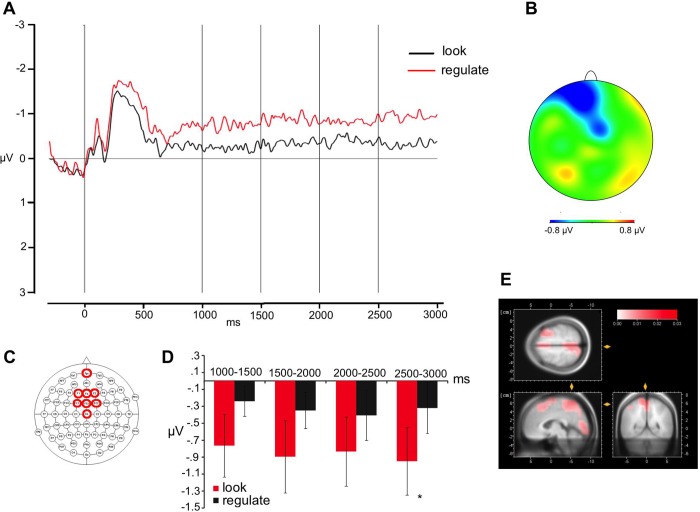
Effect of strategy.Grand average waveforms (A) at the frontal sites (indicated in C) and topographical distribution of the effect distancing minus attend (B); the first vertical line indicates the target onset; the following four vertical lines indicate the boundaries of the time windows for the analyses (1000, 1500, 2000, and 2500 ms, respectively); average activity within each time window is shown in (D). Between 2500 and 3000 ms after stimulus onset, there was a main effect of Strategy with a larger negativity for the distancing than the attend condition. (E) LORETA source reconstruction showed as the maximal source the occipital gyrus, the right middle frontal gyrus, the superior frontal gyrus, the precentral and postcentral gyrus, and the precuneus. Error bars indicate the standard error of the mean, asterisks significant differences.